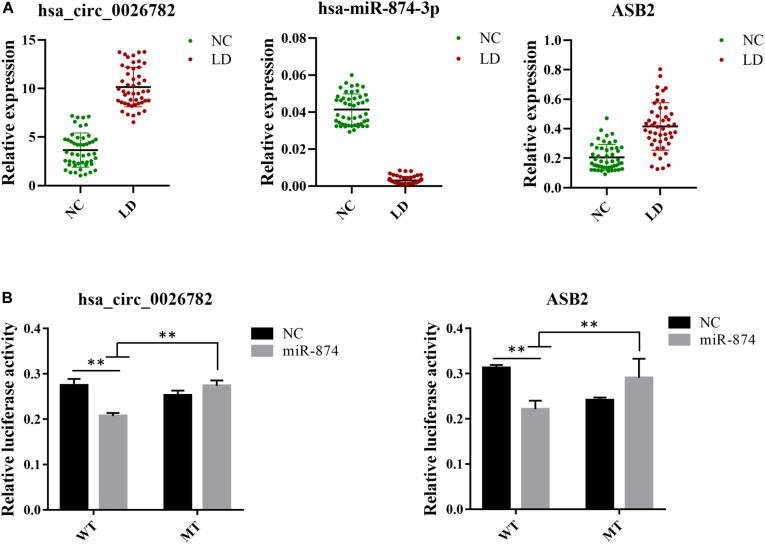
Validation of expression level and interactions among hsa_circ_0026782, hsa-miR-874-3p and ASB2. (A) Expression level of hsa_circ_0026782, hsa-miR-874-3p and ASB2. A total of 32 samples are used for verification. The results are the mean ± standard error of the mean (SEM) and were analyzed by t-tests. ∗∗: P-value < 0.01. (B) The direct interaction between hsa_circ_0026782, hsa-miR-874-3p and ASB2 is confirmed by dual-luciferase reporter gene assay.